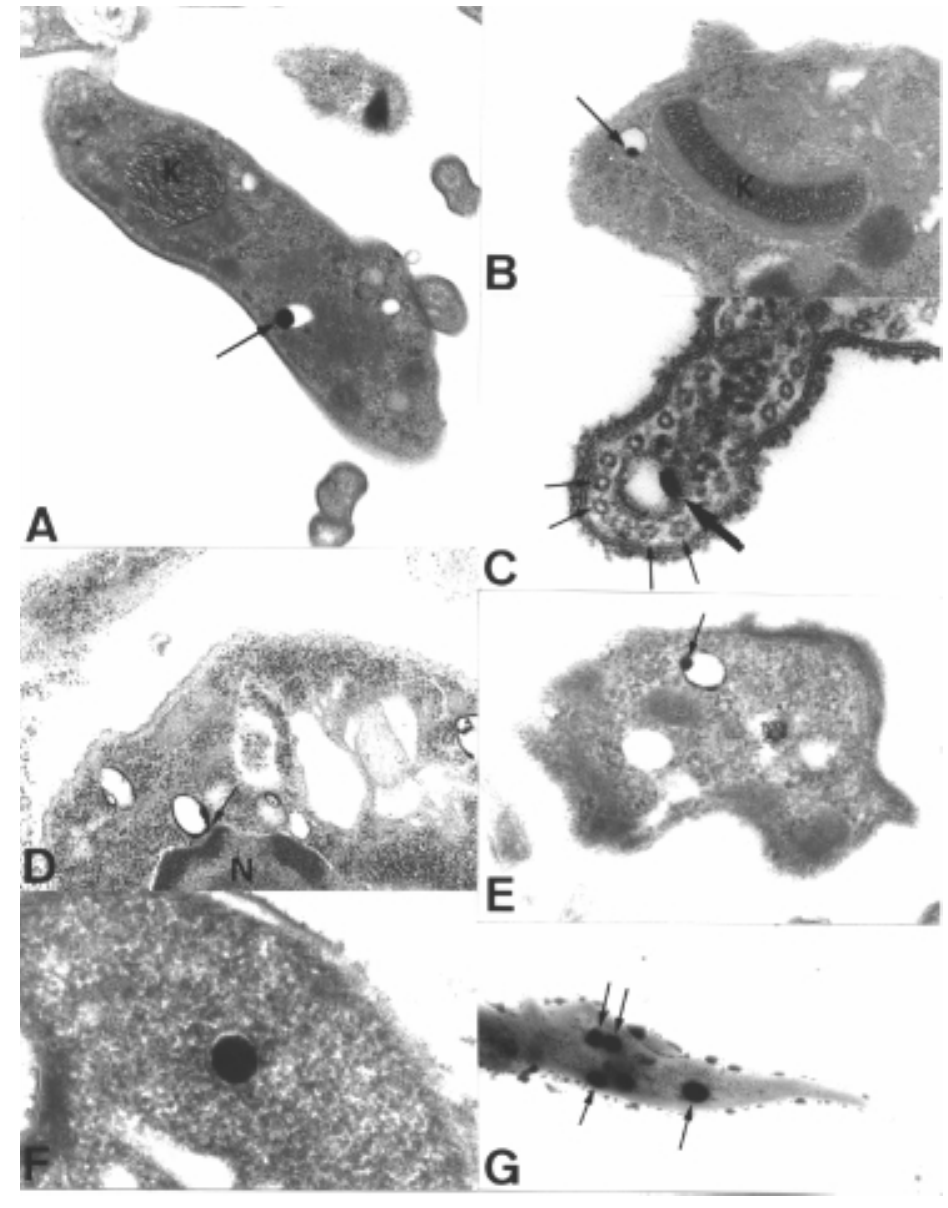
Fig. 1 – Thin sections of T. cruzi acidocalcisomes submitted to different protocols for transmission electron microscopy. The organelle can be easily recognized in Epon sections in the trypomastigote (A), epimastigote (B) and amastigote (D) forms as empty vacuoles with the electron-dense inclusion located below the acidocalcisome membrane (arrows). It can be seen in close contact with other parasite organelles such as kinetoplast (B), subpellicular microtubules (C) and nucleus (D). The morphological aspect of the acidocalcisomes remains the same in Unicryl sections (E), whereas in high pressure freezing followed by freeze substitution (F) and cryoultramicrotomy followed by freeze-drying (G) the electron- dense content is well preserved. (A) X 23,400 (B) X 27,000 (C) X 94,800 (D) X 38,300 (E) X 28,400 (F) X 82,700 (G) X 16,300.